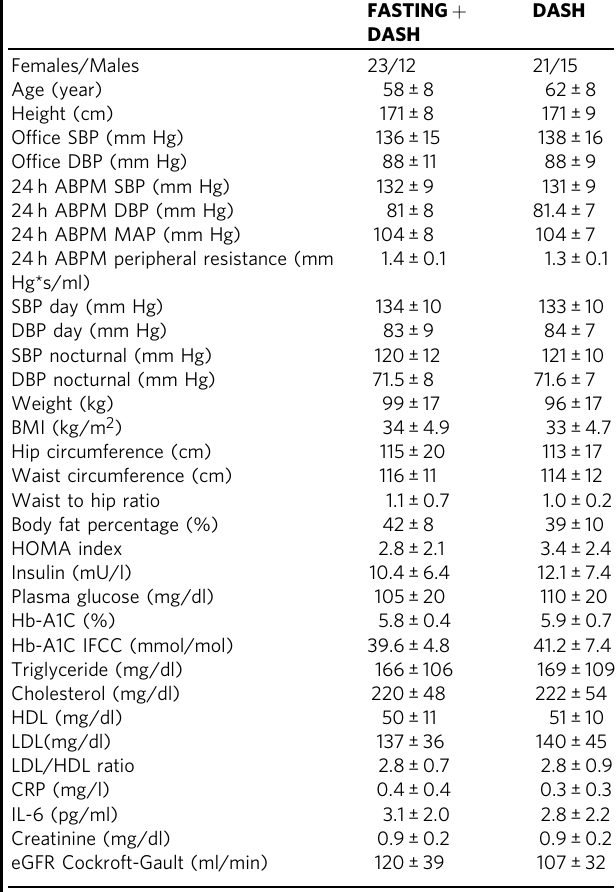
Table 1 Patient characteristics at